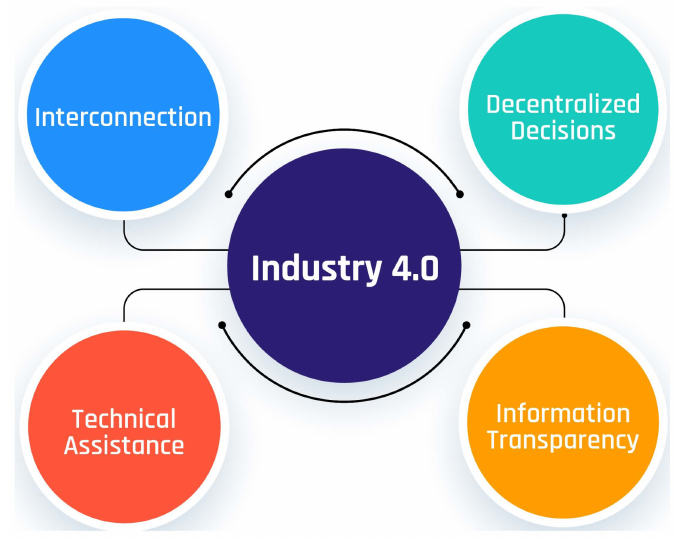
Figure 2. The four main principles of Industry